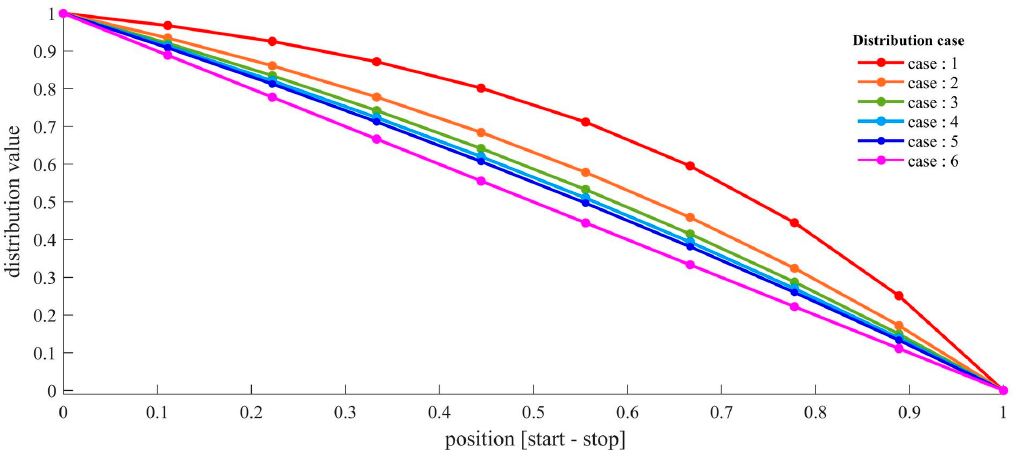
Figure 5. Distribution functions for determining the thickness of taper wing skins, ribs, and spars.